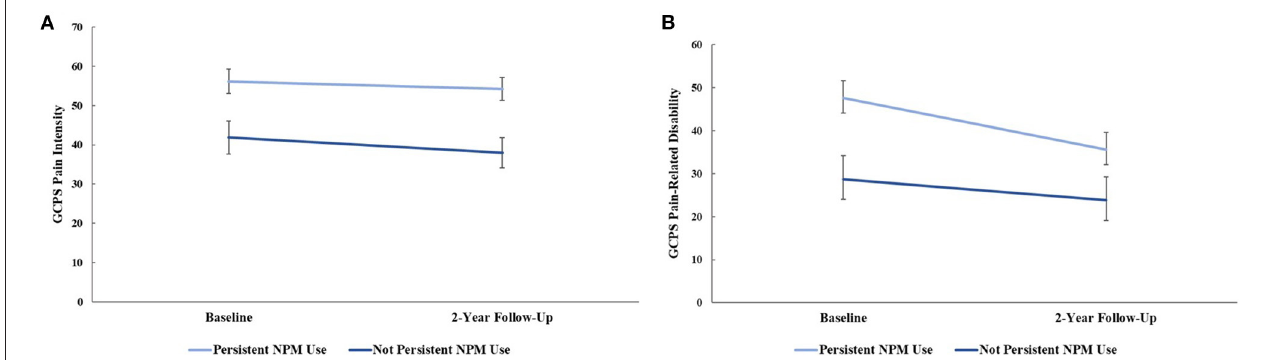
FIGURE 2 | (A) graded chronic pain scale (GCPS) pain intensity and (B) GCPS pain-related disability at baseline and 2-year follow-up between non-pharmacological pain management (NPM) groups, controlling for age, sex, and study site. Error bars represent standard